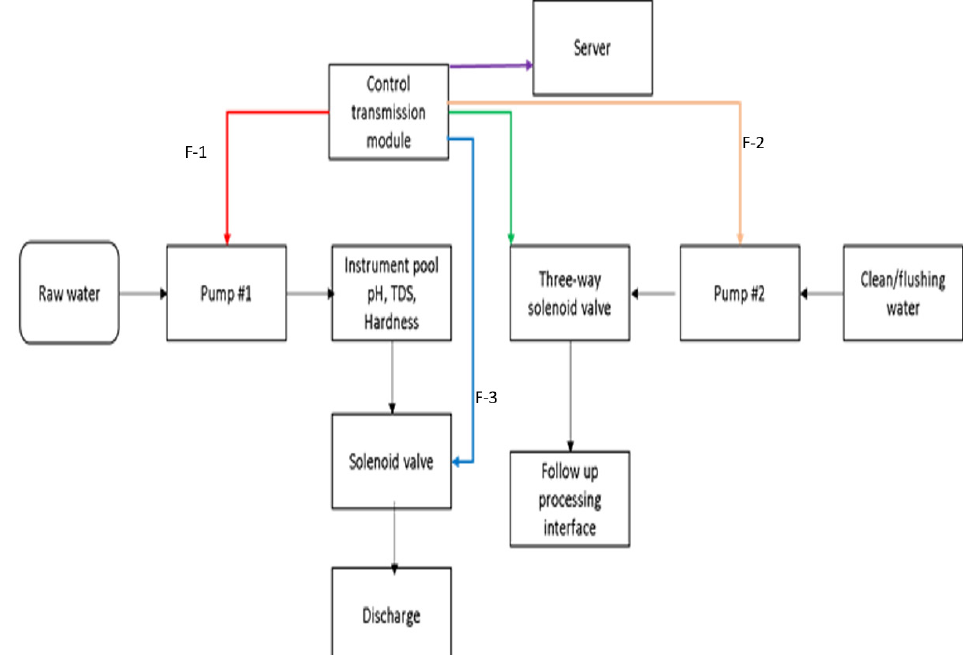
Figure 5: Flowchart of mobile phone application set